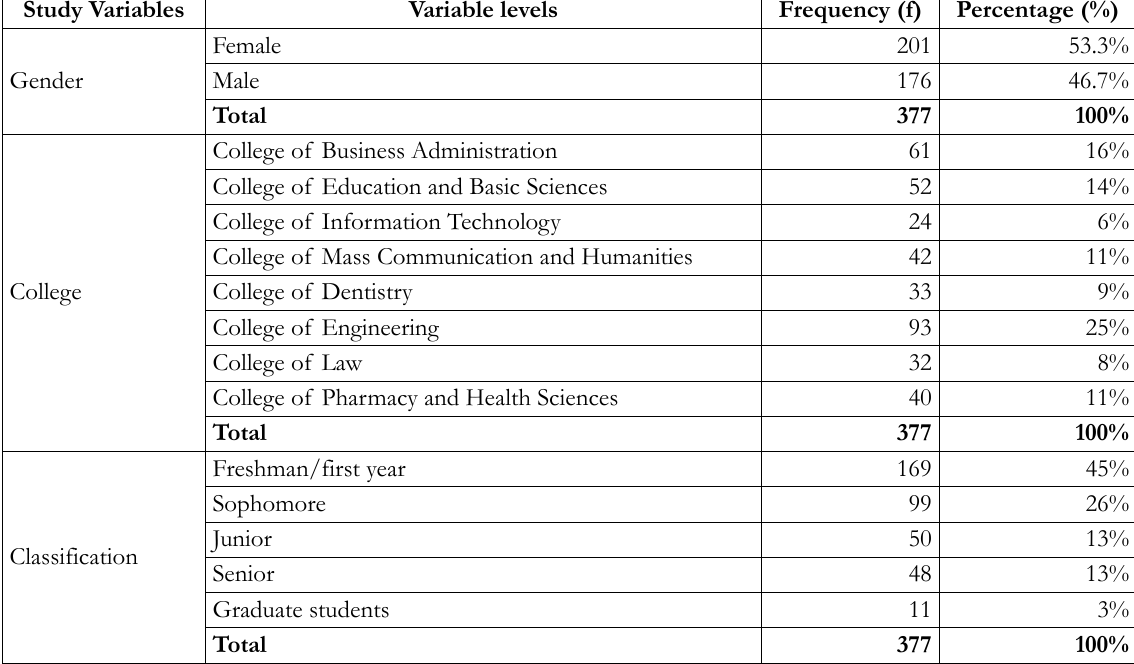
Table 3. Demographic information of the